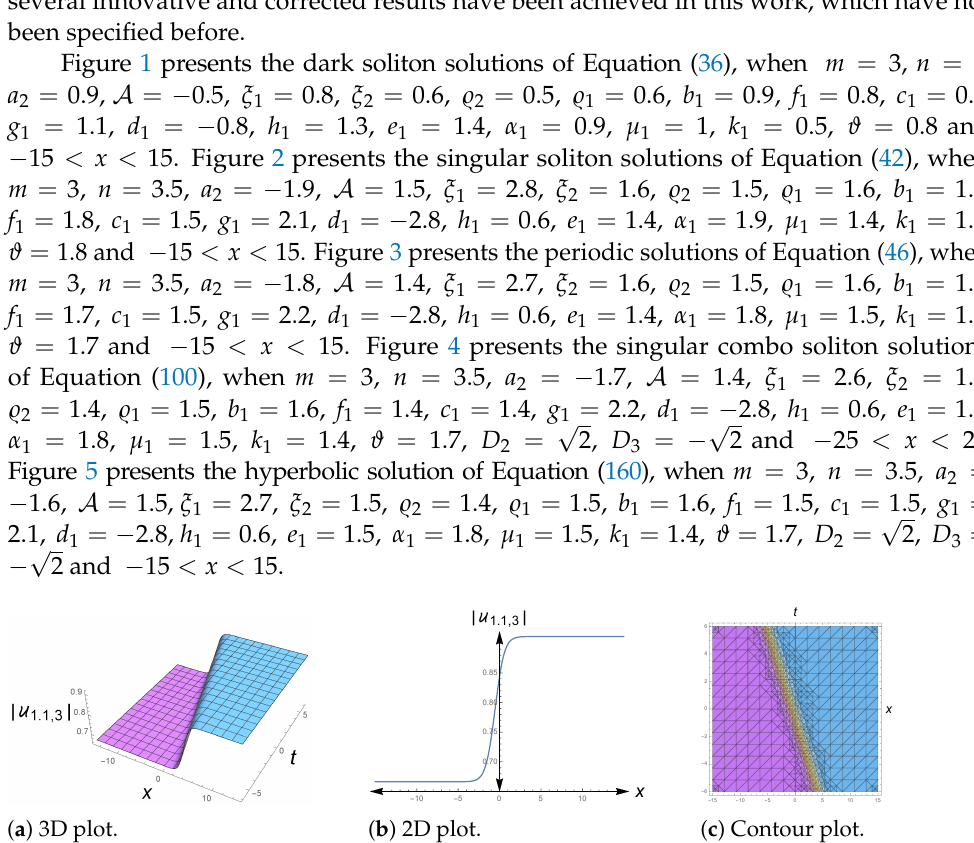
Figure 1. Graphical simulation of dark soliton solutions to Equation